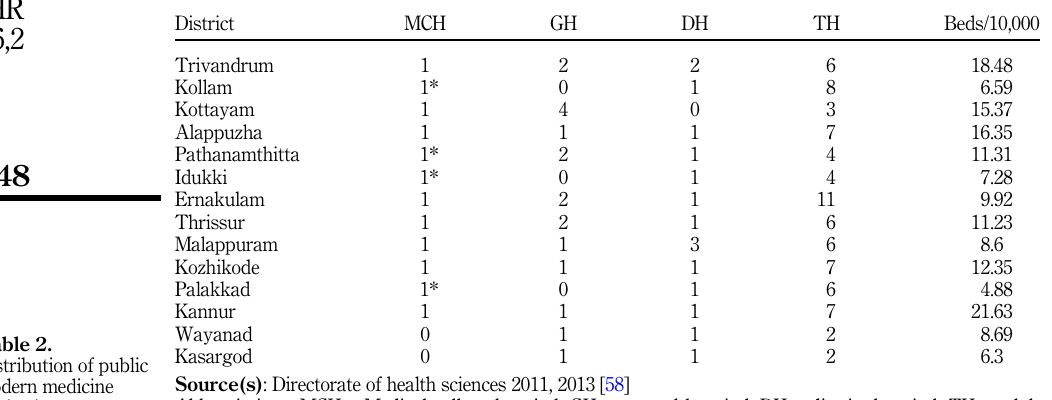
Table 2. Distribution of